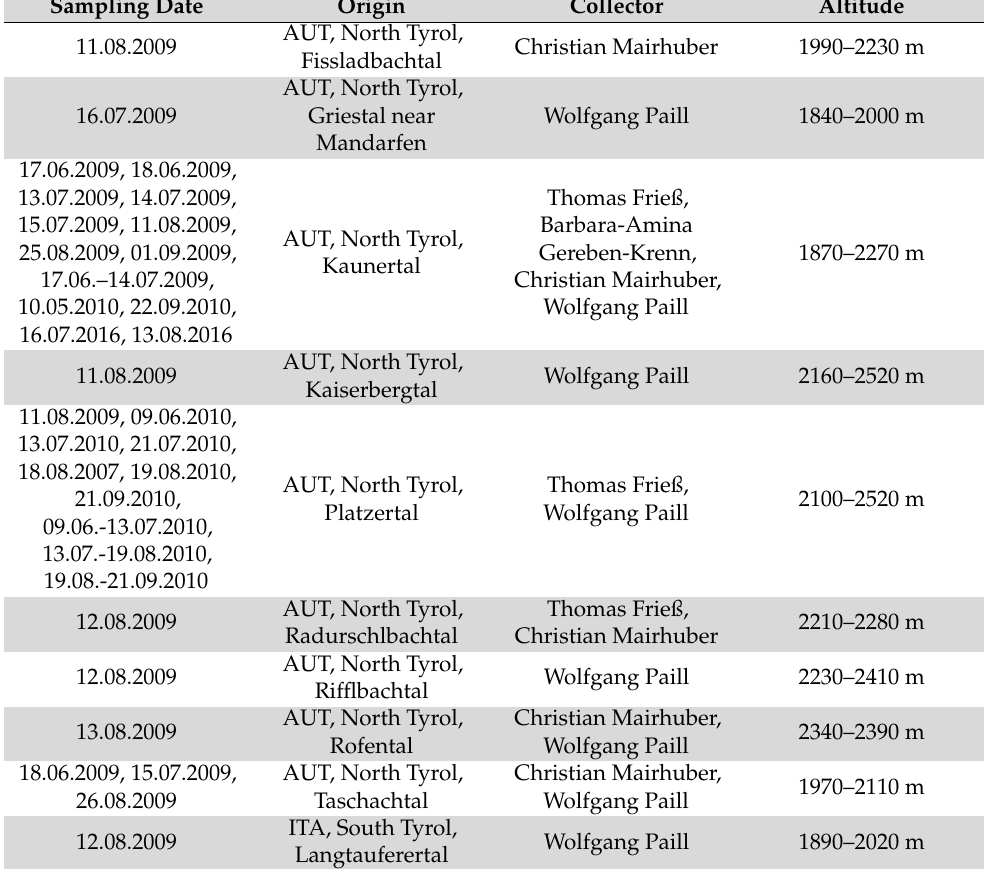
Table 1. Sampling localities and dates. The table lists details about the origin of the samples as well as the dates and ranges of altitudes that have been sampled by different collectors. Geographic coordinates are not presented in order not to endanger the populations by possible